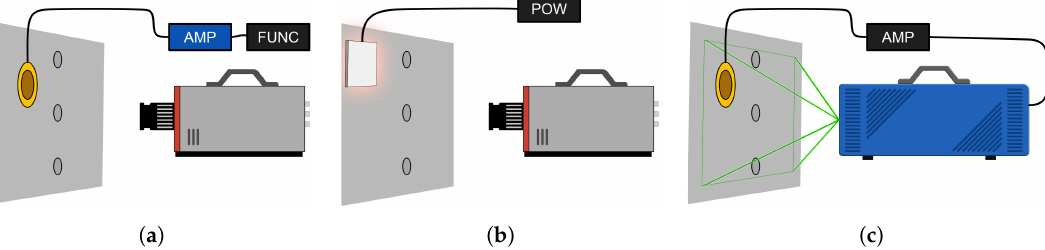
Figure 2. A sketch of the three different measurement setups. The setup of the Ultrasound Lock–In Thermography (ULT) ( a ), the setup of the In-plane Heatwave Thermography (IPHWT) ( b ) and the setup of the Scanning Laser Doppler Vibrometer (SLDV) measurements ( c